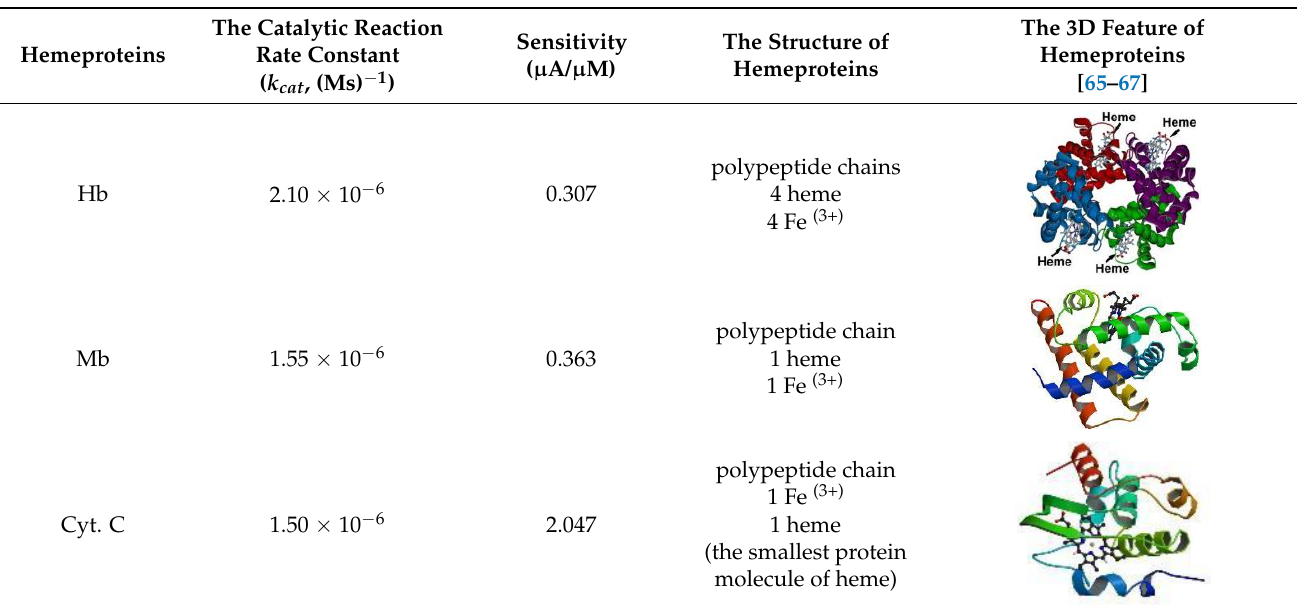
Table 2. The catalytic reaction rate constant (Figure 11) and the sensitivities (Figure 13) of hemeproteins.